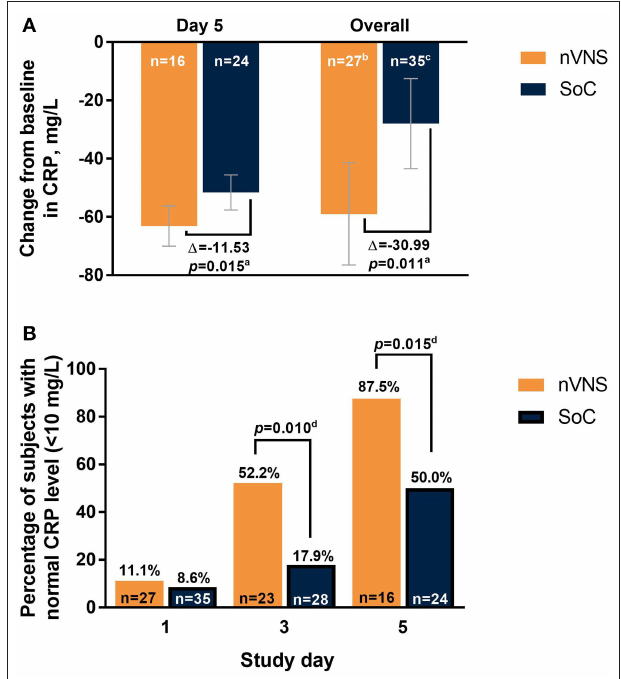
FIGURE 4 | Changes From Baseline in CRP Level (A) and Percentage of Participants With Normal CRP Levels ( < 10 mg/L) (B) by Treatment Group Among Hospitalized Patients With COVID-19. Error bars denote 95% CIs. a p values are from F tests comparing LSM changes from baseline for the nVNS and SoC groups. b 39 observations from 27 participants. c 52 observations from 35 participants. d p values are from chi-squared or Fisher exact test, as appropriate. COVID-19, coronavirus disease 2019; CRP, C-reactive protein; LSM, least squares mean; nVNS, non-invasive vagus nerve stimulation; SoC, standard of care.